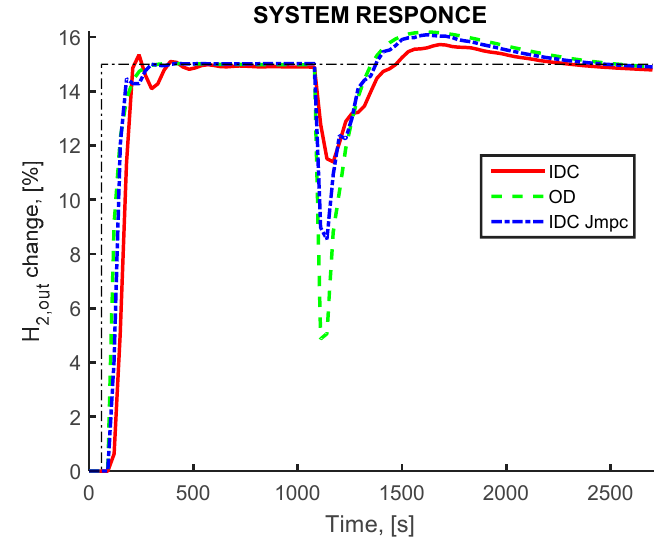
Figure 7. Pure hydrogen production rate (controlled variable). CRM flowsheet, IDC( J COST ) framework (red continuous curve) OD framework (green dashed curve) IDC( J MPC ) framework (blue dashed-dot curve). Setpoint change for hydrogen production at 150 s and disturbance influence at 1000 s.